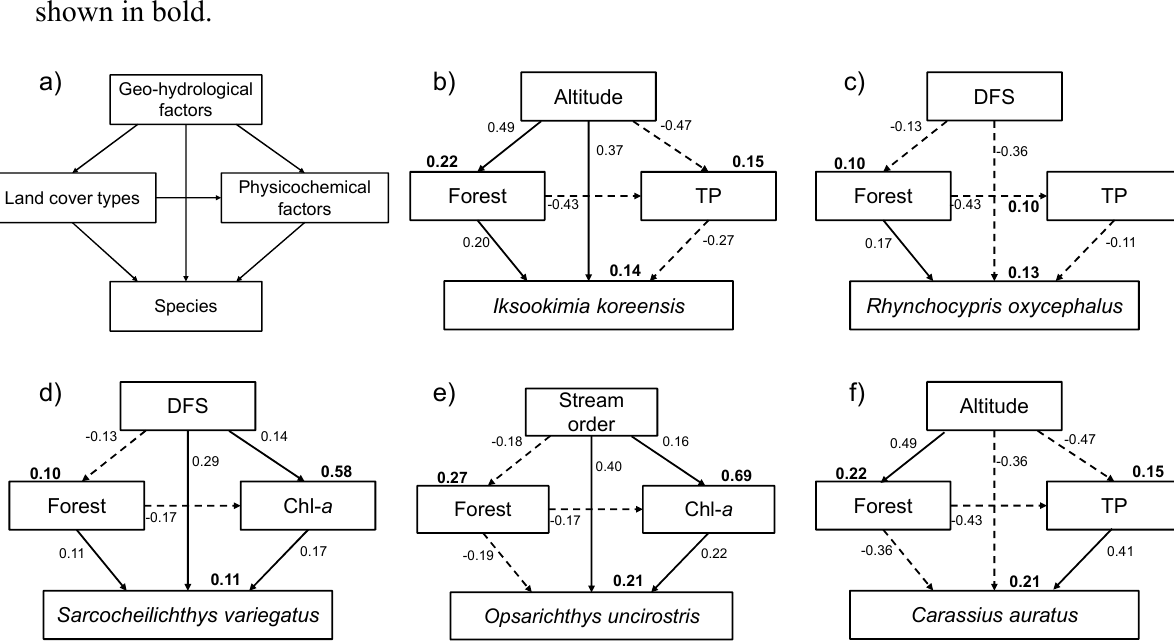
Figure 8. Path diagrams to estimate the relationship between environmental variables in 3 different subgroups (geo-hydrology, land cover type, physicochemistry) and prevalence of major species in each cluster by the self-organizing map (SOM). ( a ) Structure of path diagram, ( b ) Iksookimia koreensis (major species in cluster I), ( c ) Rhynchocypris oxycephalus (major species in cluster II), ( d ) Sarcocheilichthys variegatus (major species in cluster III), ( e ) Opsariichthys uncirostris (major species in cluster IV), and ( f ) Carassius auratus (major species in cluster V). Arrows represent directed relationships. Solid lines indicate significantly ( P < 0.05) positive relationships and broken lines indicate significantly ( P < 0.05) negative relationships. R 2 values by linear multiple regression are shown in